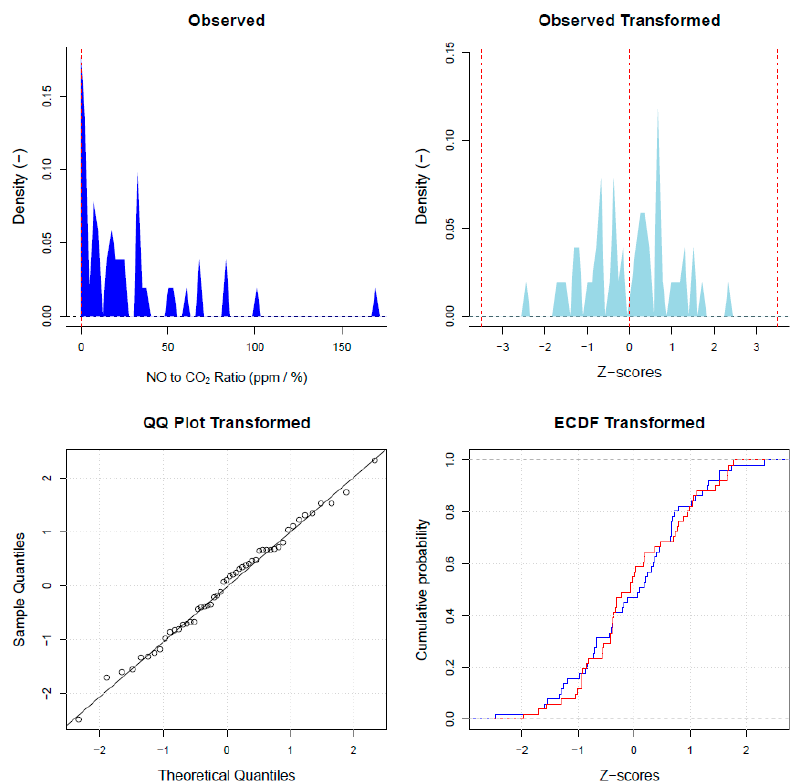
Figure 4. Example (petrol Euro 2 LCV): transforming NO emission distributions for outlier. ECDF: empirical cumulative distribution function.